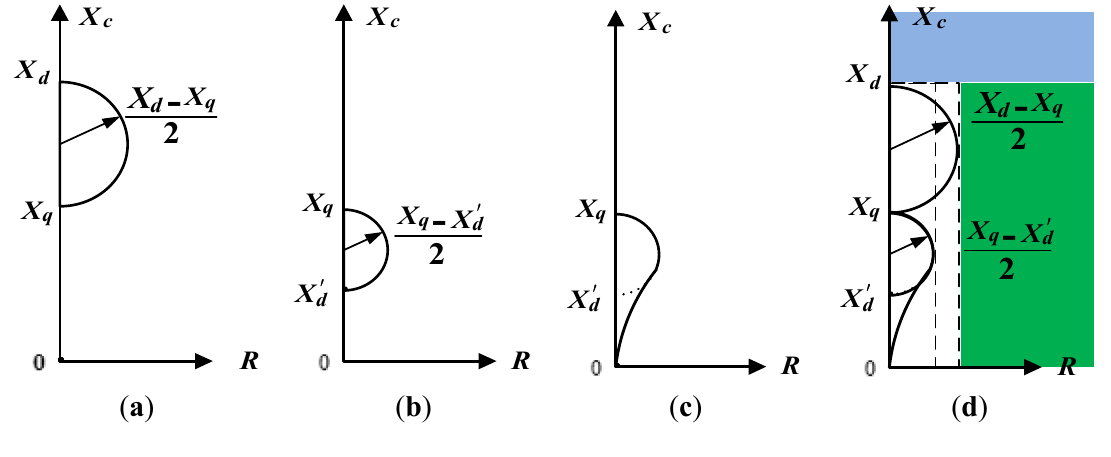
Figure 2. ( a ) Area of reaction synchronous self-excitation; ( b ) area of repulsion synchronous self-excitation; ( c ) area of asynchronous self-excitation; and ( d ) integrated area of